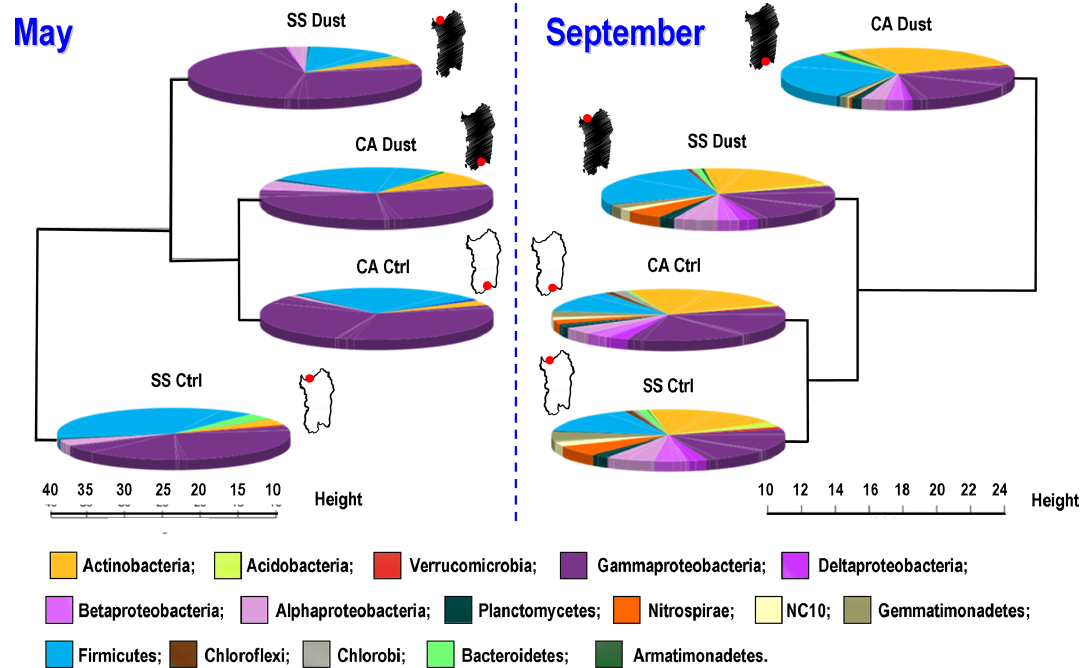
Figure 3. Pie charts of percent relative abundance and cluster analysis dendrograms (Euclidean distance method, complete linkage) con- structed on the identified bacteria grouped at the phylum/class rank level, as stemming from the OTU annotation of the DNA sequencing from the filtered atmosphere sampling. SS: Sassari station, northern Sardinia; CA: Cagliari station, southern Sardinia; Dust: collection dur- ing dust outbreaks brought by winds from Africa; Ctrl: control, collection upon opposite wind front change, following (May) or preceding (September) the dust outbreak. The data available from the two 12h sub-periods (hours 0–12 and hours 12–24) collected during the dust events were merged together in the corresponding pie charts to be compared at an equal sampling duration with the 24h control samples. The Sardinia contour map in white (control) or black (dust) and the red dot, pointing at the sampling site, are shown. The squares providing a color legend to the taxa names follow a corresponding clockwise order of their possible presence on each pie chart. Table 1. Percent frequency of sequences belonging to the indicated orders in the averaged data of all samplings (dust and control) of each sampling period (May or September). Data in which frequencies were higher than 1% in at least one of the two seasons are reported. These represent 91.1% of the total sequences for the May sampling (on a total of 65 orders found) and 79.4% of the September sampling (on a total of 118 orders found). Means ± standard deviation are